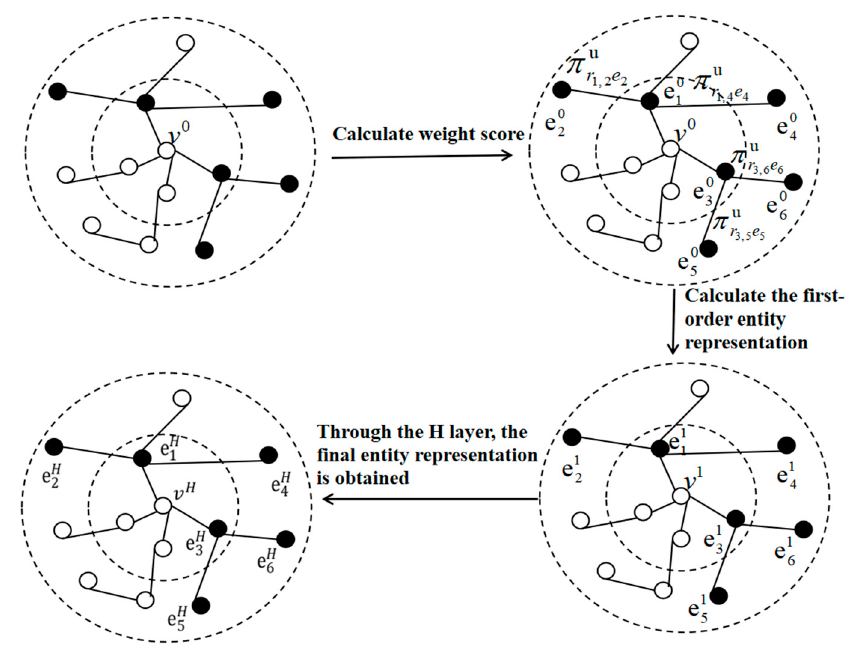
Figure 2. The process of knowledge graph information aggregation.